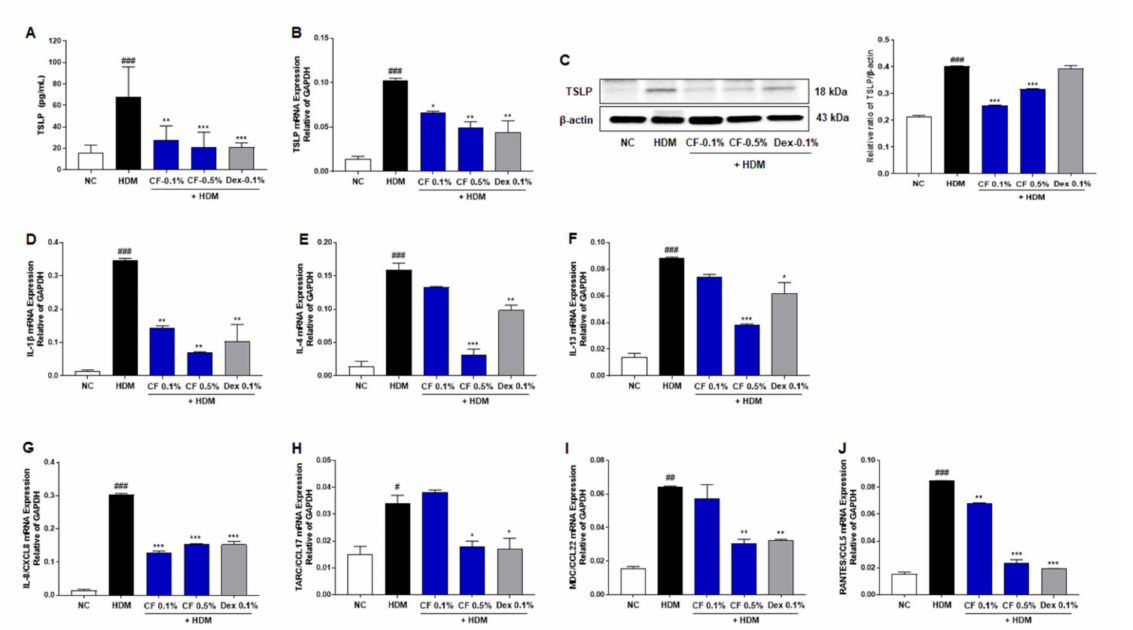
Figure 4. Effects of CF on the TSLP and inflammatory cytokines/chemokines in the HDM-induced AD mouse model. ( A ) TSLP serum levels were measured by ELISA. ( B ) The relative expression of TSLP was analyzed by real-time PCR in dorsal skin samples, with normalization against levels of GAPDH . ( C ) The expression of TSLP was detected by western blotting in dorsal skin samples. β -Actin was used as an internal control. The relative expression levels of inflammatory cytokines/chemokines were analyzed by real-time PCR in dorsal skin samples. Values were normalized against GAPDH expression levels. Normalized levels of the cytokines ( D ) IL-1 β , ( E ) IL-4, and ( F ) IL-13 expression in dorsal skin samples are shown. Normalized levels of the chemokines ( G ) IL-8/CXCL8, ( H ) TARC/CCL17, ( I ) MDC/CCL22, and ( J ) RANTES/CCL5 expression in dorsal skin samples are shown. All data are presented as means ± SEM (n = 6 mice per group). Differences among groups were evaluated by one-way ANOVA, with Dunnett’s post-hoc tests; # p < 0.05, ## p < 0.01, and ### p < 0.001 compared with the NC group; * p < 0.05, ** p < 0.01, and *** p < 0.001 compared with the HDM